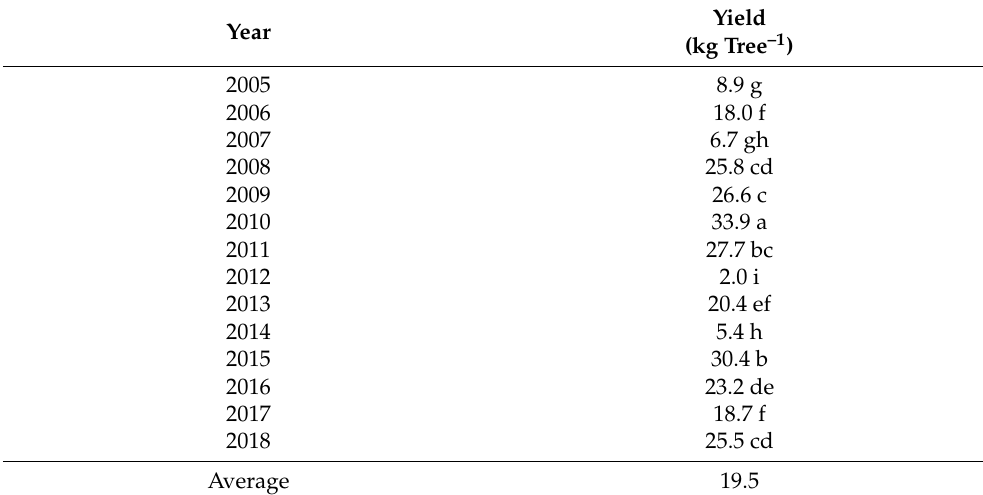
Table 1. Influence of the year on olive